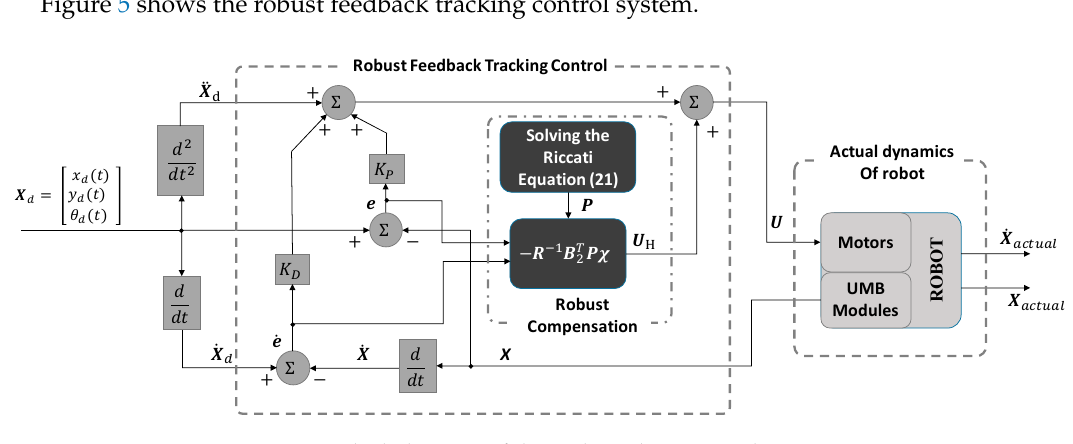
Figure 5. Block diagram of the path tracking control system.